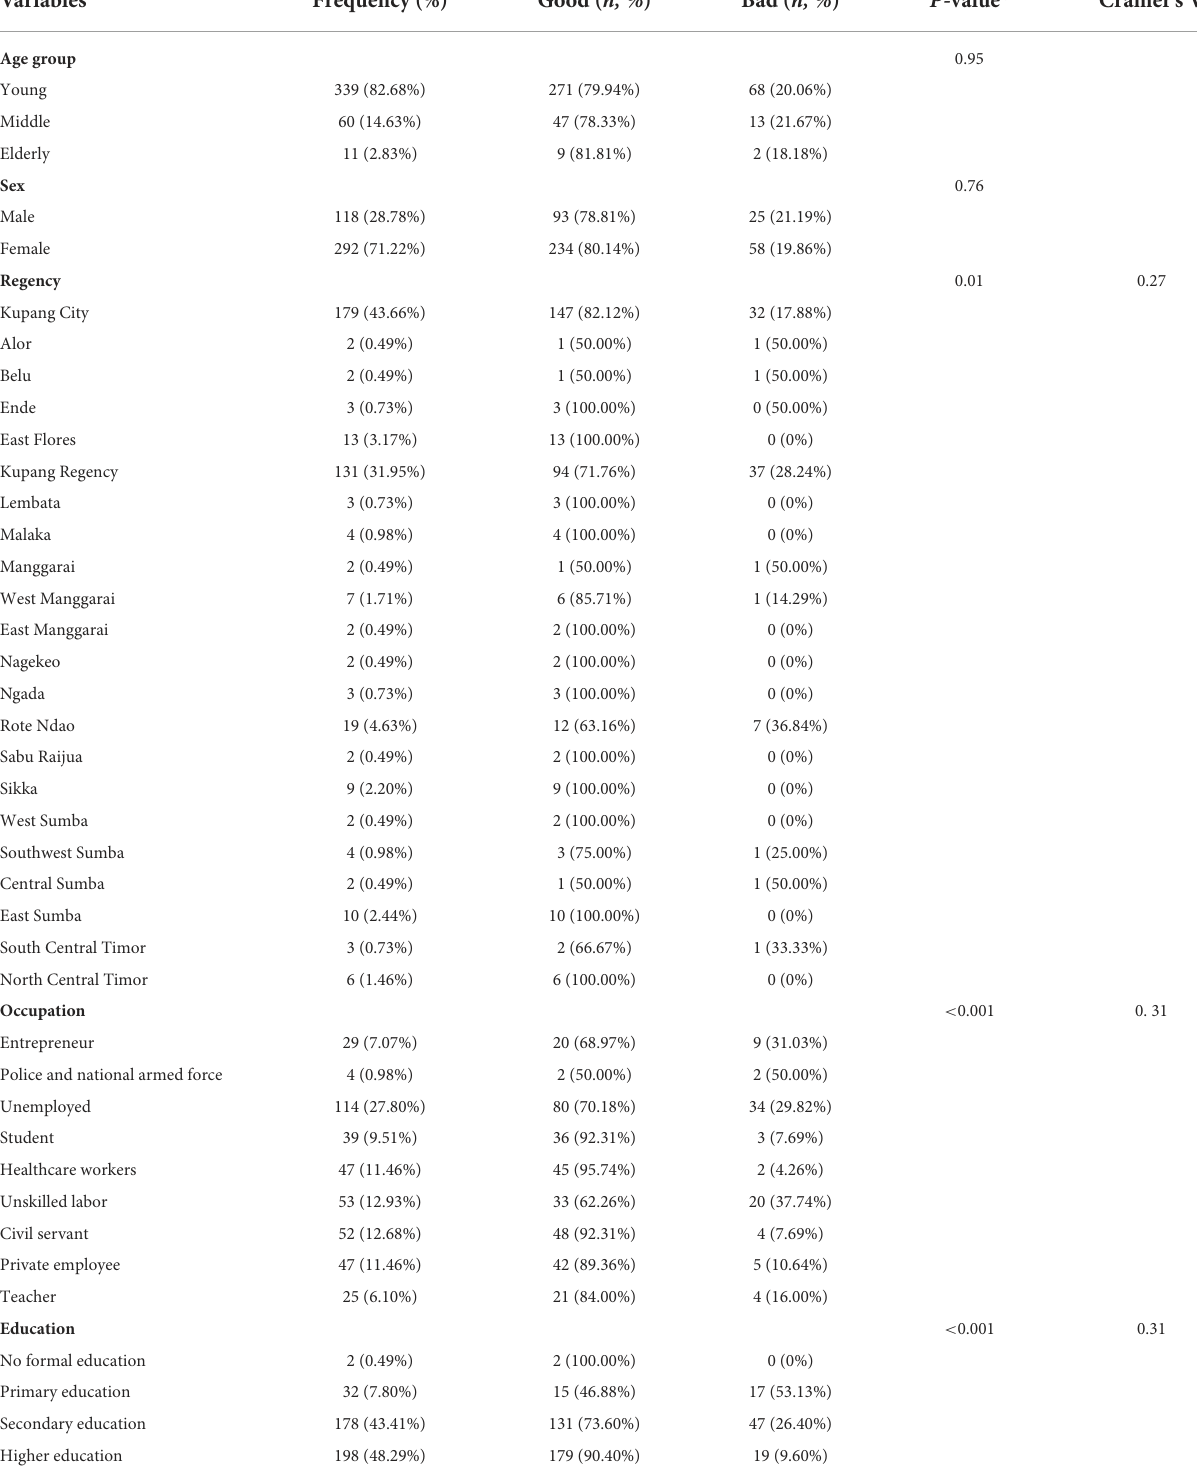
TABLE 3 Knowledge toward COVID-19 by socio-demographic characteristics ( n =